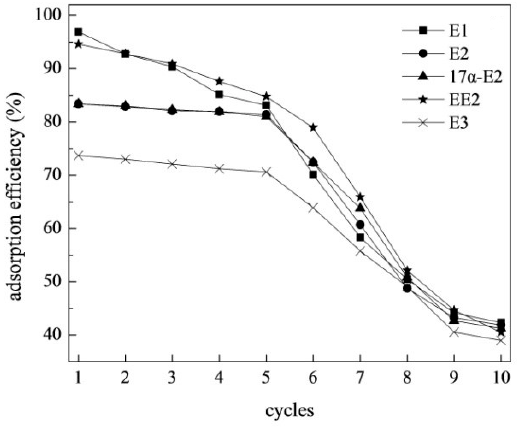
Figure 10. The efficiency of regenerated and reused MGO to adsorption of estrogens.